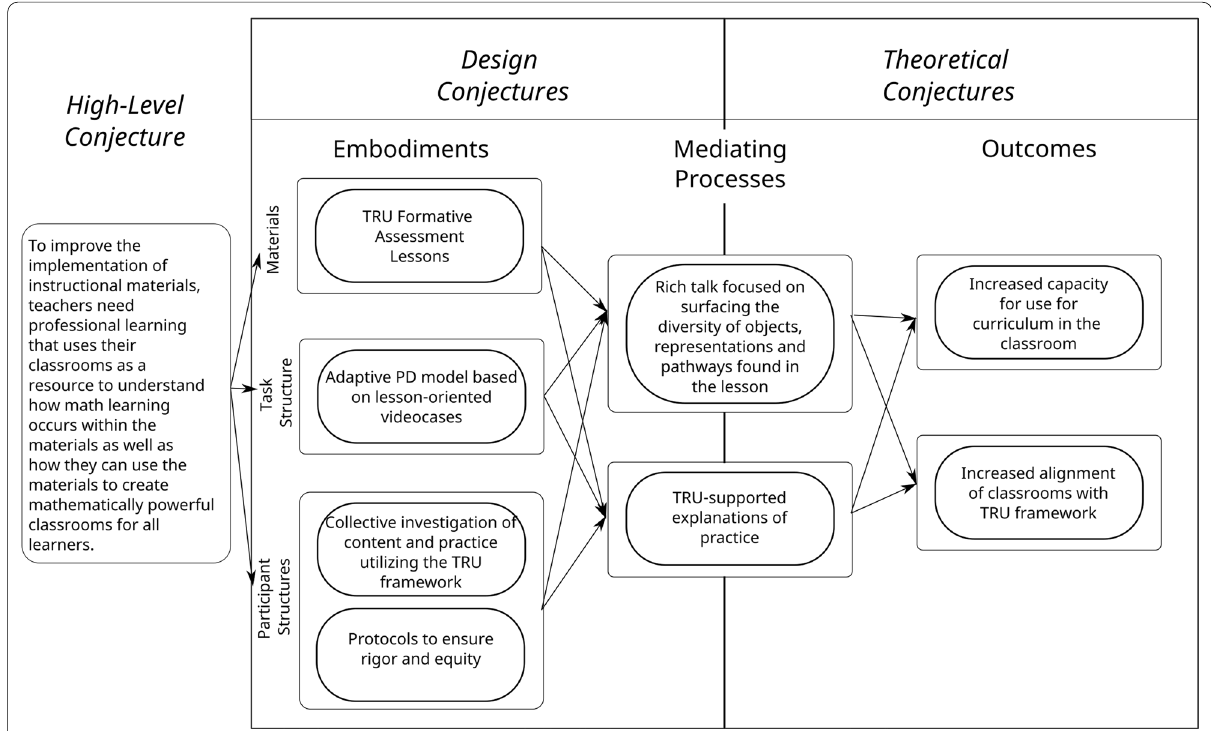
Fig. 7 Revised conjecture